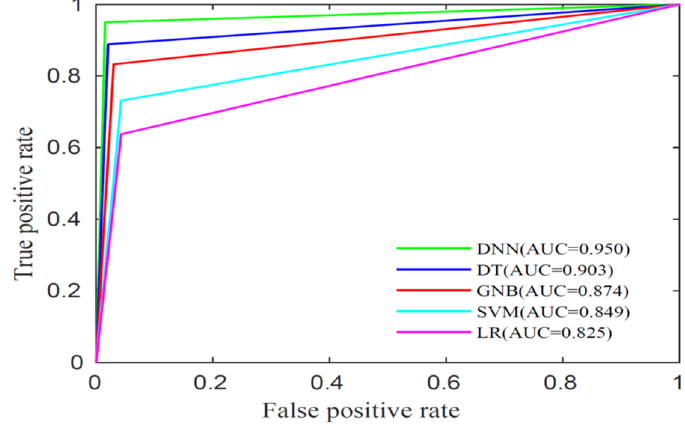
Figure 7. ROC for different classifier models training dataset. Algorithm 1. Region blocking of sub ‐ image size N × N.